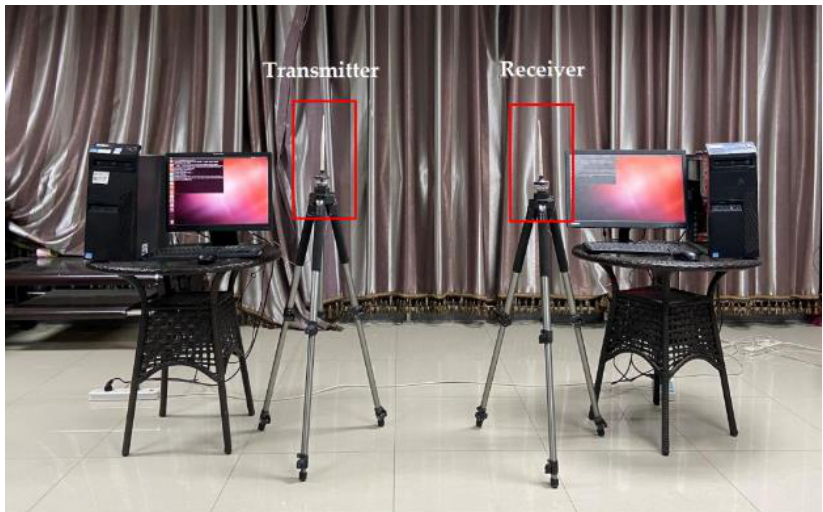
Figure 9. Experiment